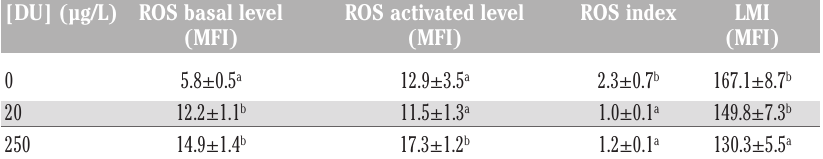
Table 2. Effects of depleted uranium on leucocyte parameters during the in vivo experi- ment. Values are means of 20 replicates, except for controls values (n=18); standard error is